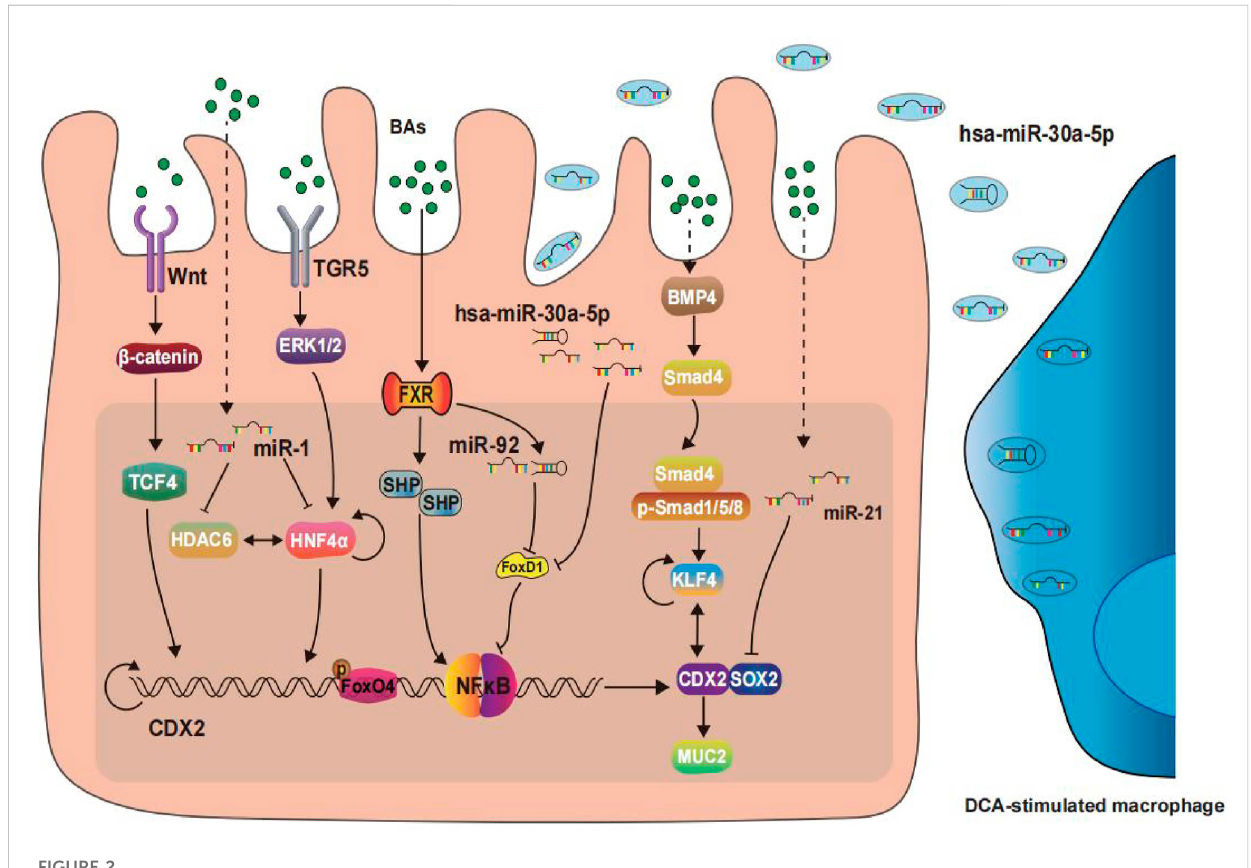
FIGURE 2 Signaling pathways and transcription factors in the development of gastric intestinal